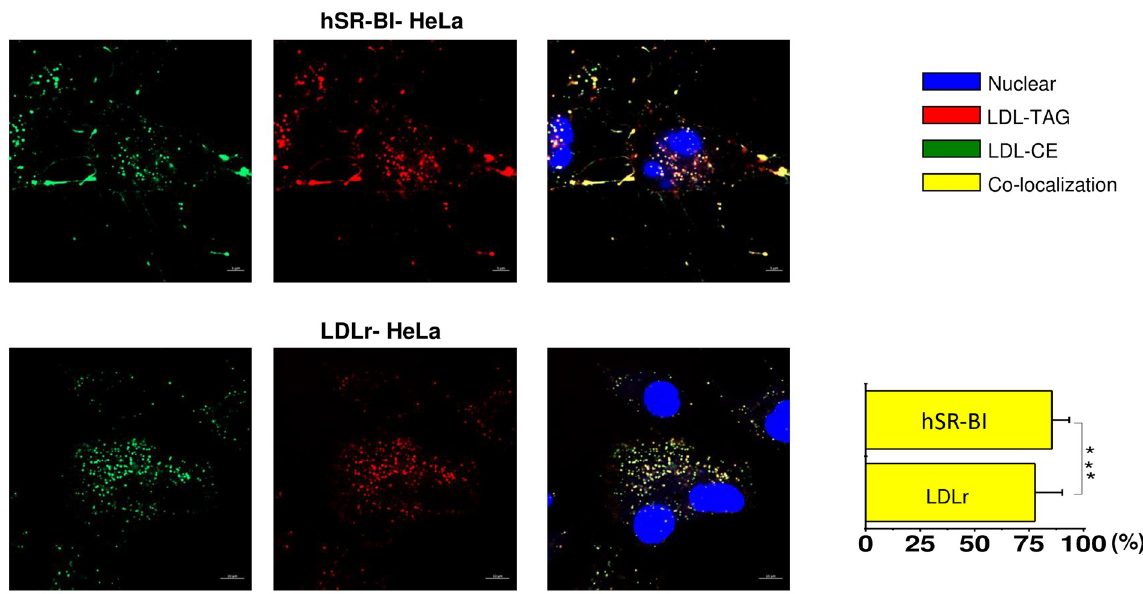
Fig 8. Transport of LDL core NL in various HeLa cells. HeLa cells were plated at 30% confluency on a glass cover slips and pre-incubated in serum free media for 24 hours prior to experiments. Dual BP-CE/BP-TG labeled LDL were added to the media for 1 hour, washed and chased for 60 minutes in serum/lipoprotein free media. The color code and extent of co-localization are shown in the right columns. The cell type is specified at the top of the figure. The bar corresponds to 10 μ m, ��� p > 0.1.